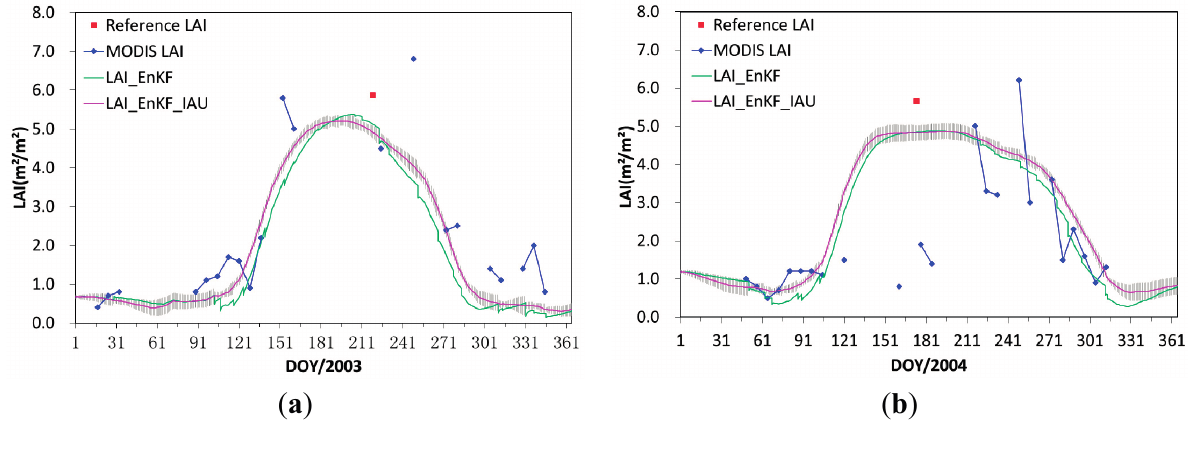
Figure 5. Retrieved LAI profile by the inversion method with IAU at the center pixel of ( a ) the Larose site in 2003 and ( b ) the Sonian site in